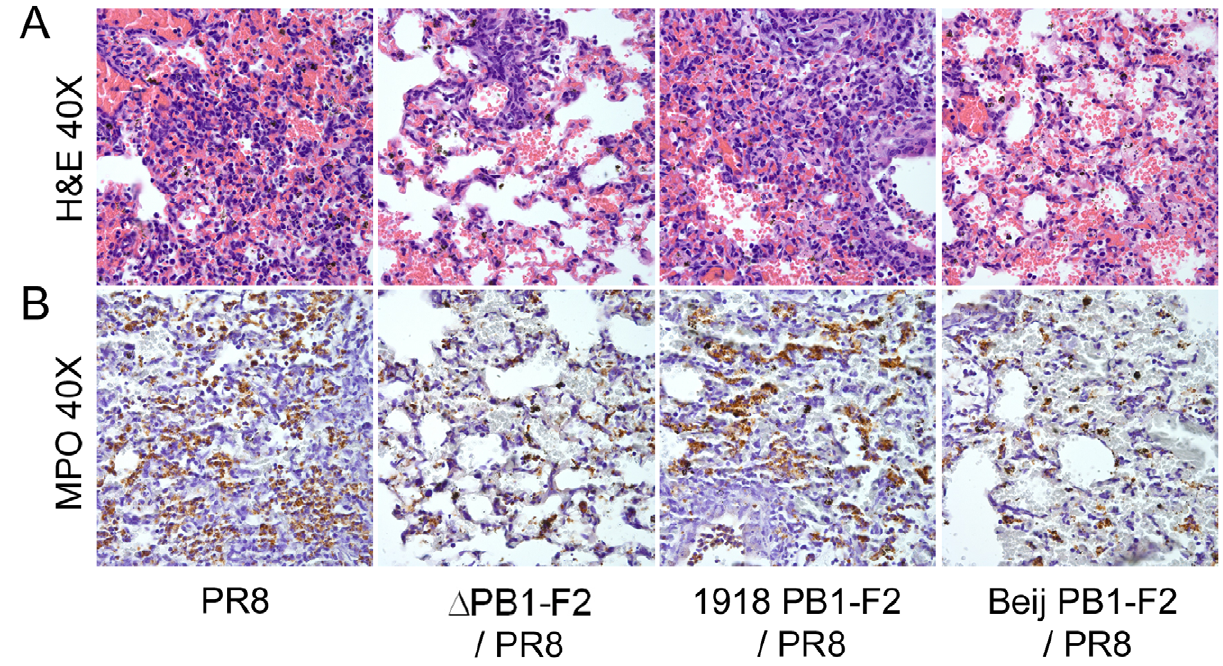
Figure 7. PB1-F2 contributes to influenza virus mediated immunopathology. Groups of mice were infected with a panel of viruses as indicated (see methods for definitions) and euthanized 72 hours post-infection. Lungs were removed, sufflated, sectioned, and examined for histopathology following A) staining with hematoxylin and eosin or B) application of an antibody specific for MPO followed by a horse-radish peroxidase-conjugated secondary antibody, staining with chromagen DAB, and counterstaining with